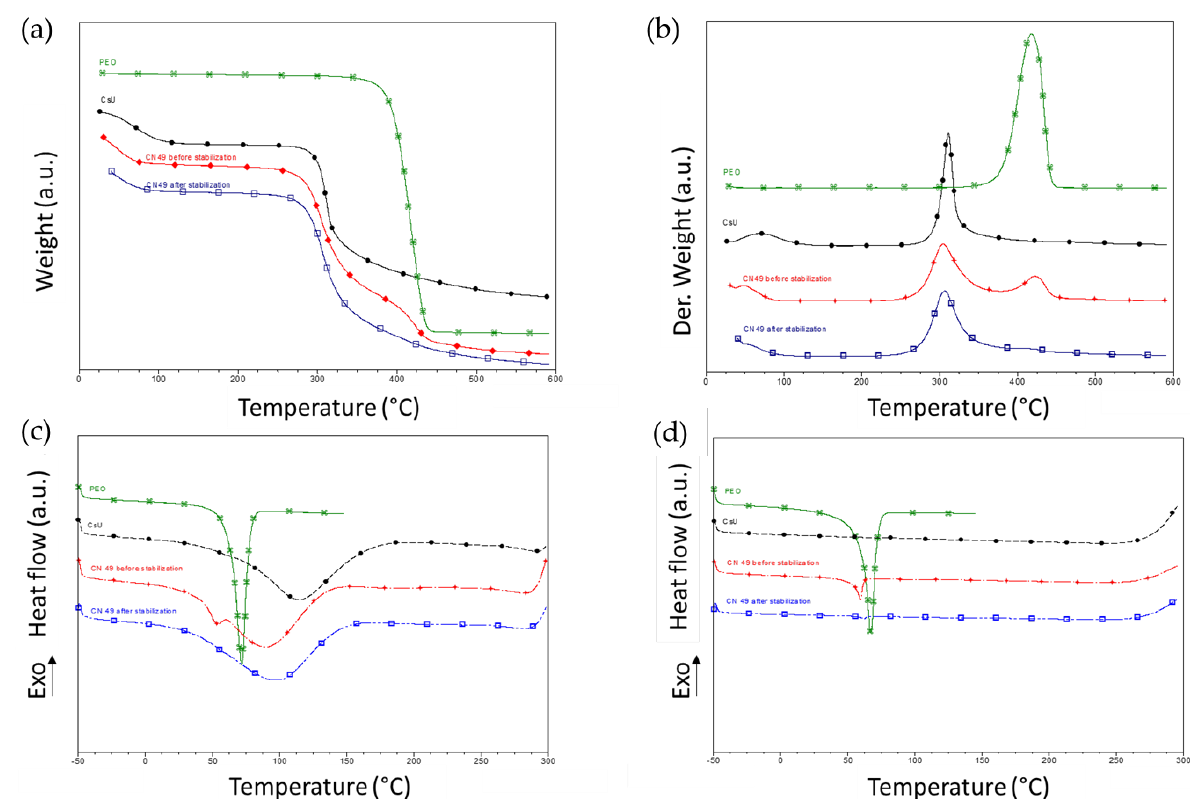
Figure 6. Thermal behavior of CsU1 (black traces), PEO (green curves), CN49 mat before (red traces) and after (blue traces) stabilization and purification. TGA curves ( a ) and TGA derivatives ( b ); DSC curves first ( c ) and second ( d ) heating ramps.